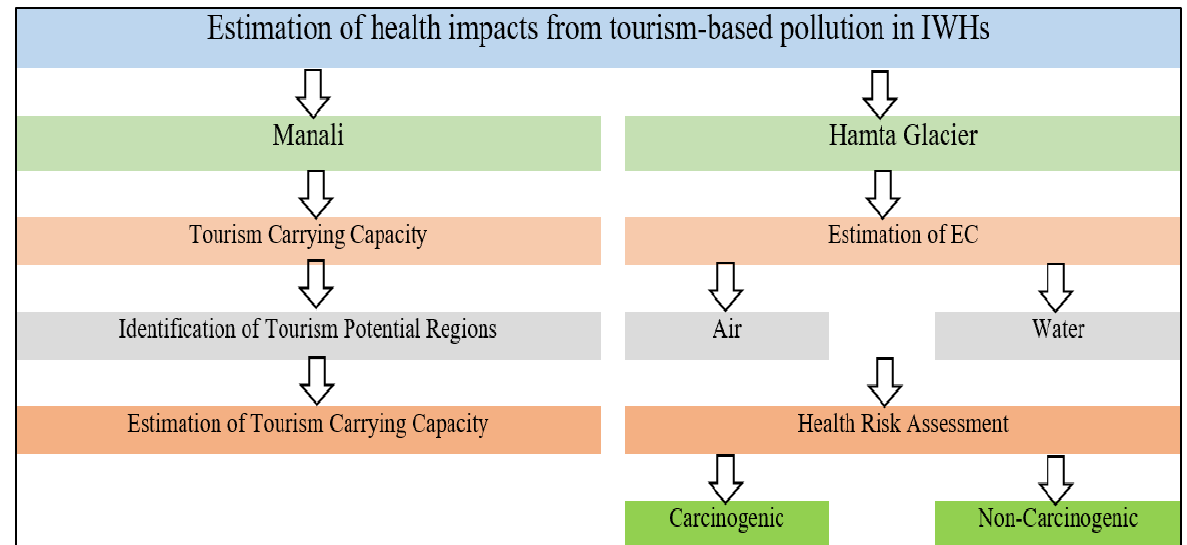
Figure 3. Geographical location of Manali, Himachal Pradesh, India.